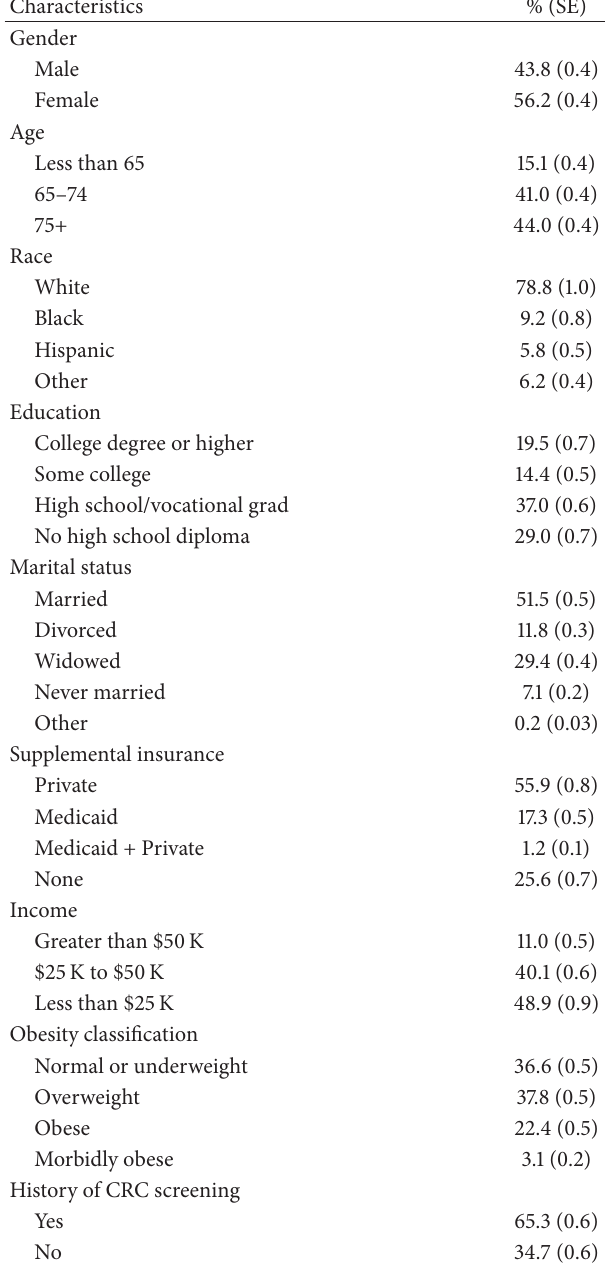
Table 2: Demographic characteristics of Medicare beneficiaries aged 50 years and older in 2005 ∗